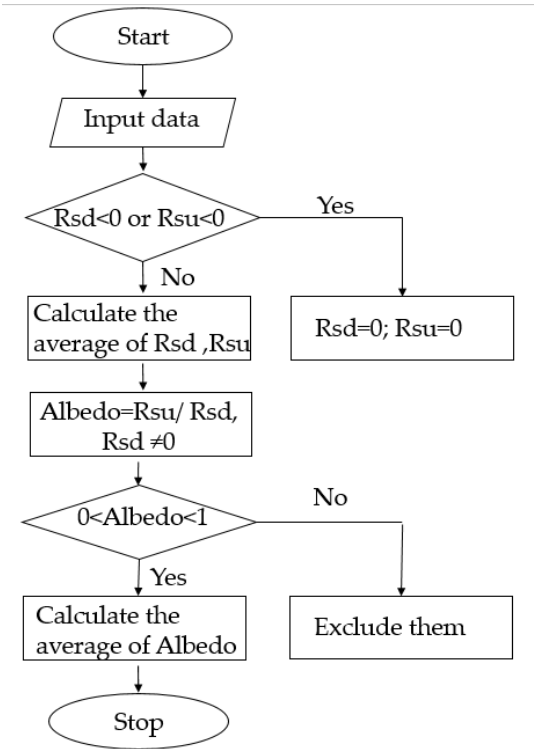
Figure 3. Flowchart representing the steps to process Rsd, Rsu, Albedo. Rsd is downward shortwave radiation, Rsu is upward shortwave radiation.